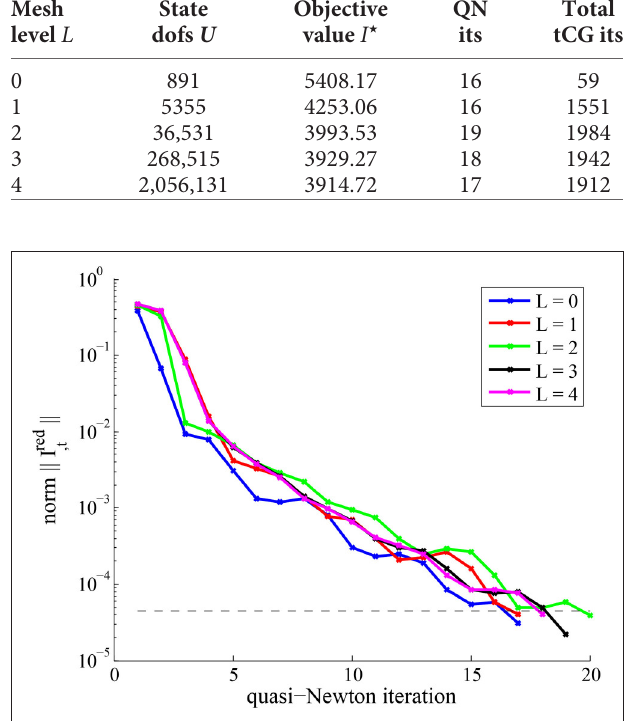
FIGURE 3 | Numerical results from the quasi-Newton method for Example 6. Top: Number of iterations for various mesh refinement levels L . Bottom: Convergence behavior of the quasi-Newton method for various levels L .